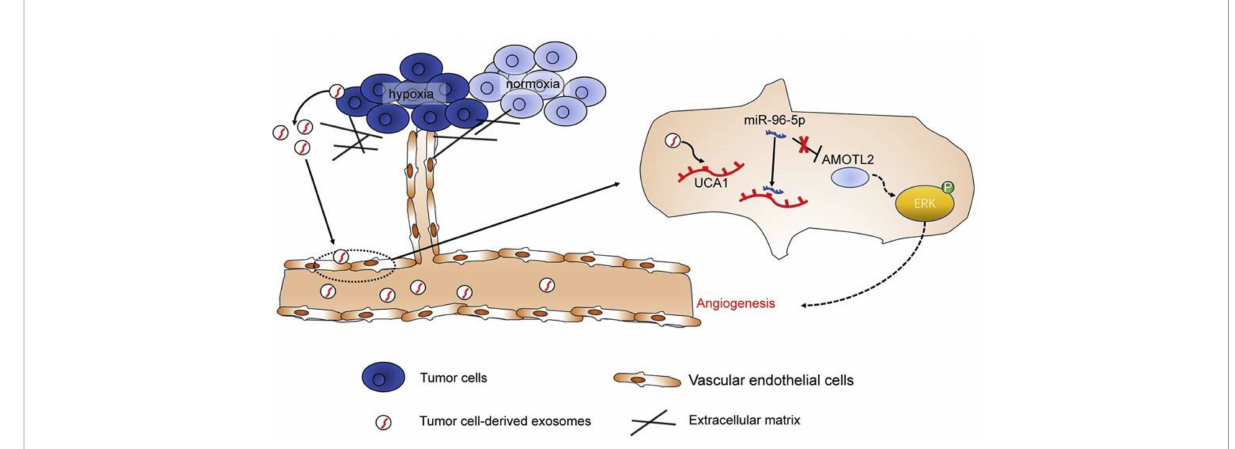
FIGURE 4 The lncRNA-UCA1 derived from exosomes of hypoxic cancer cells induces angiogenesis via the miR-96-5p/AMOTL2 axis in pancreatic cancer (PC). In summary, the hypoxic microenvironment, a crucial component of solid tumors, encourages the release of exosomes from tumor cells and increases tumor angiogenesis. Human umbilical vein endothelial cells (HUVECs) responded well to hypoxic exosomes produced by PC cells in terms of tube formation and cell migration. Exosomes derived from hypoxic PC cells were shown to have signi fi cant levels of the long non-coding RNA (lncRNA) UCA1, which could then be transferred to HUVECs via the exosomes. microRNA (miR)-96-5p was sponged by UCA1, which counteracted the suppressive effects of miR-96-5p on its target gene AMOTL2 expression. Hypoxic exosomal UCA1 might act as a potential target for PC therapy by promoting tumor development and angiogenesis through the miR-96-5p/AMOTL2/ERK1/2 axis. This fi gure was adapted from Guo et al.